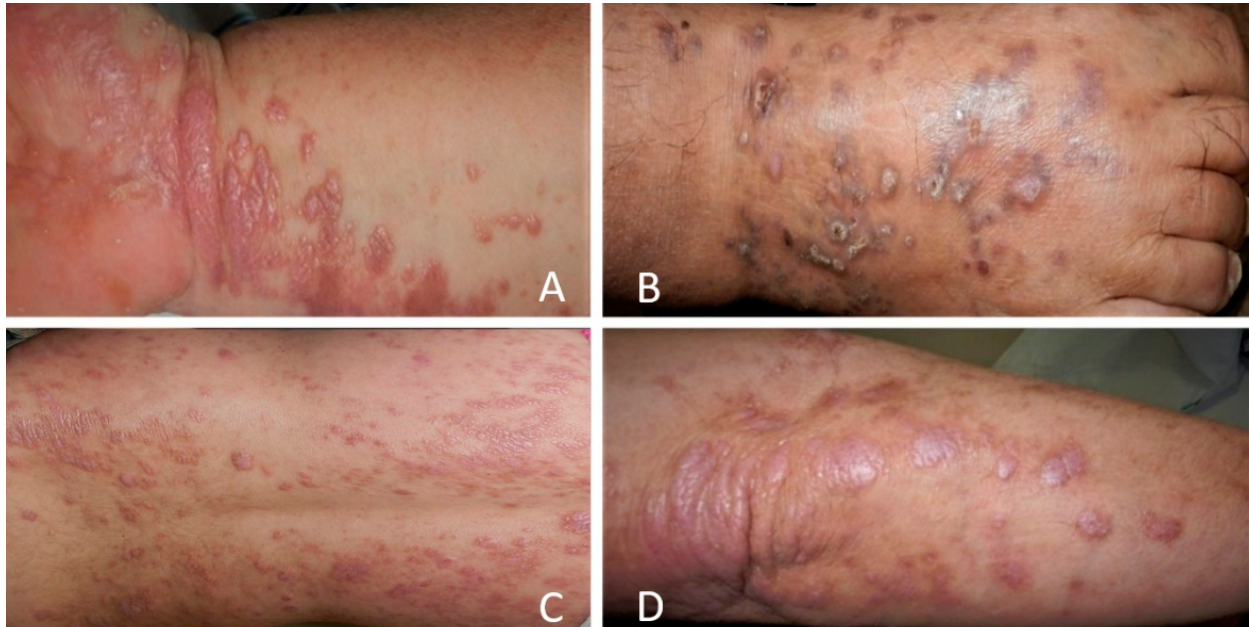
Figure 2. Clinical aspect of CLP. Small, polygonal, flat-topped, violaceous papules that may coalesce into plaques ( A )—plaques on the wrist, ( B )—dorsal aspect of the foot, ( C )—disseminated papules and plaques on the back, ( D )—plaques on the elbow.